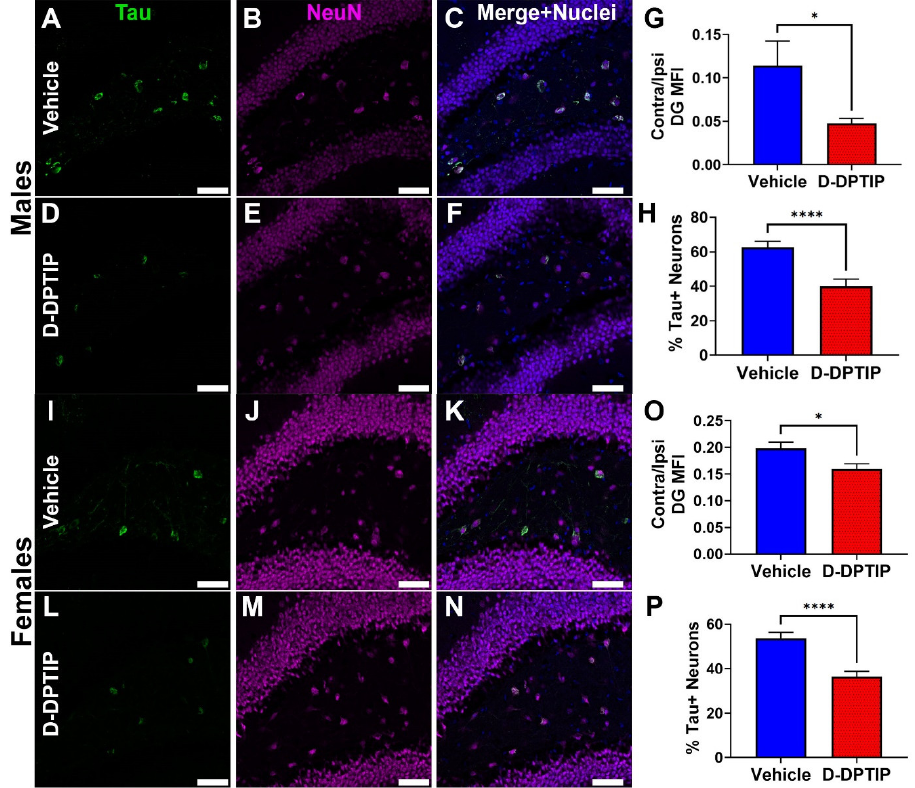
Figure 8. D-DPTIP inhibits the propagation of mutant hTau. ( A – F ) Representative images from male mice treated with empty dendrimer vehicle ( A – C ) or D-DPTIP ( D – F ) showing Thr181 tau staining in green ( A , D ), NeuN staining in magenta ( B , E ), and merged with nuclei stained blue ( C , F ). ( G ) Quantification of the mean fluorescence intensity of the ratio between contralateral and ipsilateral dentate gyrus Thr181 staining from male mice. ( H ) Quantification of the percentage of tau positive neurons in the contralateral hilus region of the DG from male mice. ( I – N ) Representative images from female mice treated with empty dendrimer vehicle ( I – K ) or D-DPTIP ( L – N ) showing Thr181 tau staining in green ( I , L ), NeuN staining in magenta ( J , M ), and merged with nuclei stained blue ( K , N ). ( O ) Quantification of the mean fluorescence intensity of the ratio between contralateral and ipsilateral dentate gyrus Thr181 staining from female mice. ( P ) Quantification of the percentage of tau positive neurons in the contralateral hilus region of the DG from female mice. Scale bar, 50 µm. Bars represent mean ± SEM. * p < 0.05. **** p < 0.0001. Importantly, chronic D-DPTIP dosing was well tolerated. Animals treated with D- DPTIP 3×/week for 6 weeks did not exhibit any overt toxicities or significant alterations in their body weight throughout the course of treatment (Figure S10A,B). Additionally, clin- ical chemistry parameters measured at the end of the experiment did not differ from the normal ranges observed in our facility and those reported by Jackson Laboratories [73– 75], Charles River [76], or Taconic [77] (Figure S10C). There was a mild but significant elevation in blood urea nitrogen (BUN) levels in both the male and female D-DPTIP treated mice; however, the extent of the elevation was within the reference ranges from both healthy animals in our facility and those reported by others [73–77]. Therefore, we conclude that chronic D-DPTIP dosing was well tolerated in the mice throughout this ex- periment.